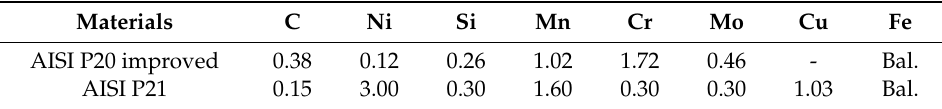
Table 1. Chemical compositions of materials used in this study